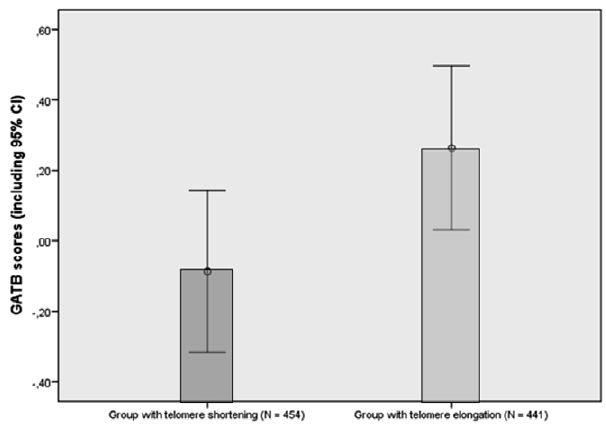
Figure 1. Mean intelligence scores of participants with telomere length shortening and telomere length elongation. ifference in scores on the GATB: F=.049, p=.036.